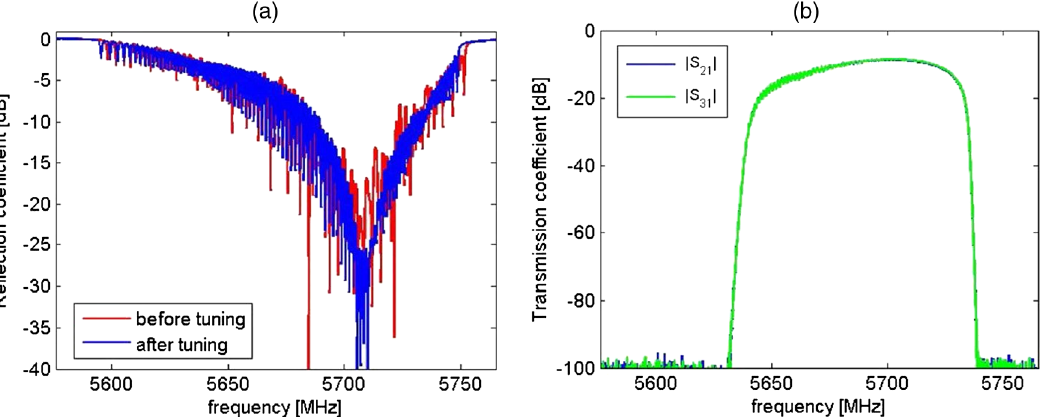
FIG. 13. Reflection coefficient at the input port before and after tuning for the sixth tuned structure (a); measured transmission coefficient between the input port and the output ones after tuning (b).